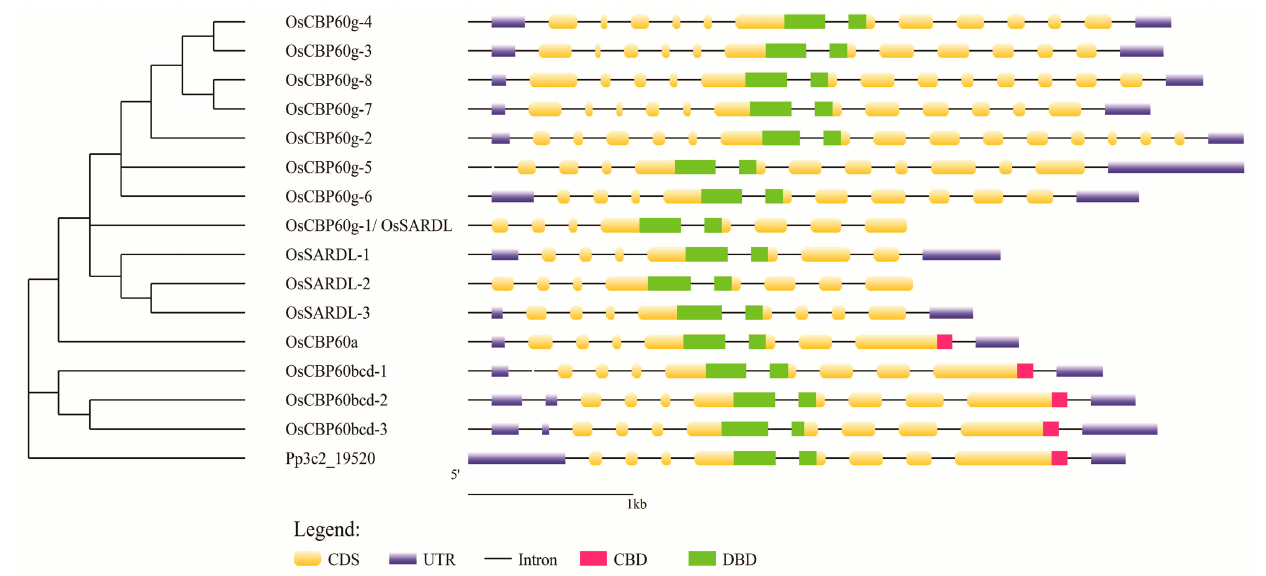
Figure 2. Gene structure analysis comparing the exon-intron structure, and the position of predicted Calmodulin-binding domain (CBD) and DNA-binding domain (DBD) encoding regions of rice OsCBP60 proteins, with that of a root sequence from Physcomitrella patens. The figure was created using the Gene Structure Display Server (GSDS 2.0).